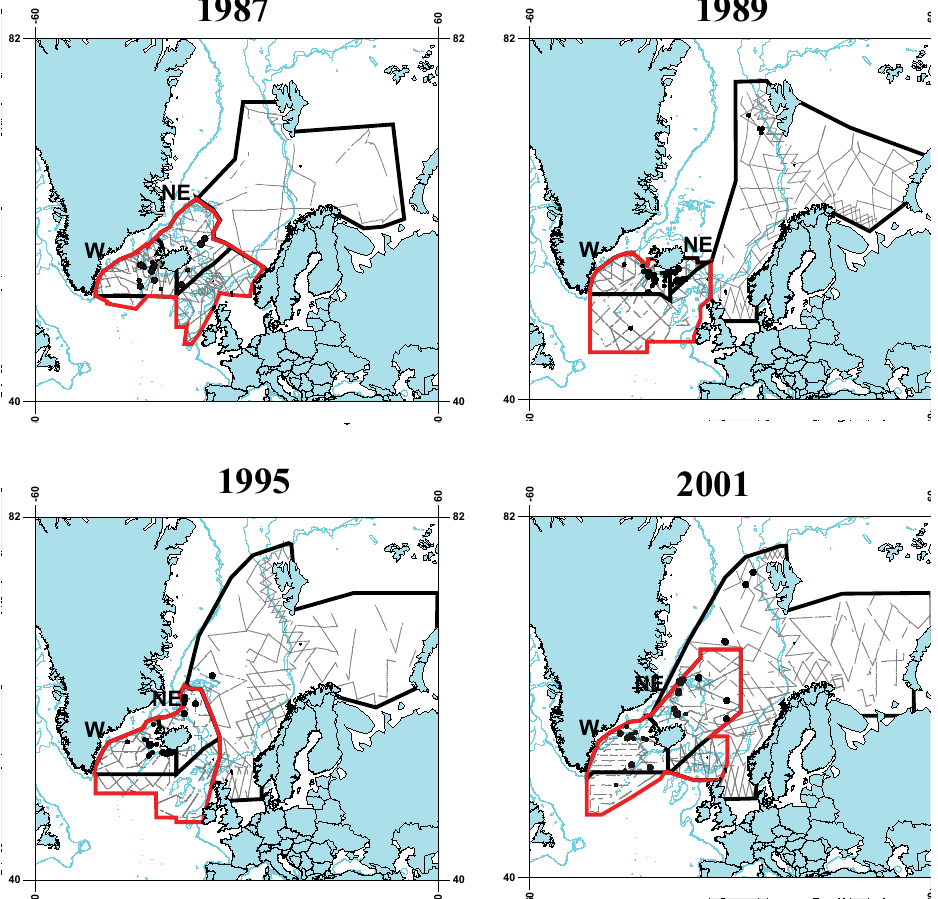
Fig. 1. Realized survey effort and sightings of blue whales in NASS ship surveys, 1987 to 2001. Symbol size is proportional to group size from 1 to 4+. The Norwegian sector of the 2001 survey was surveyed from 1996-2001. Regions identified are WEST (W) and NORTHEAST (NE), and the total area used in abundance estimates is outlined in